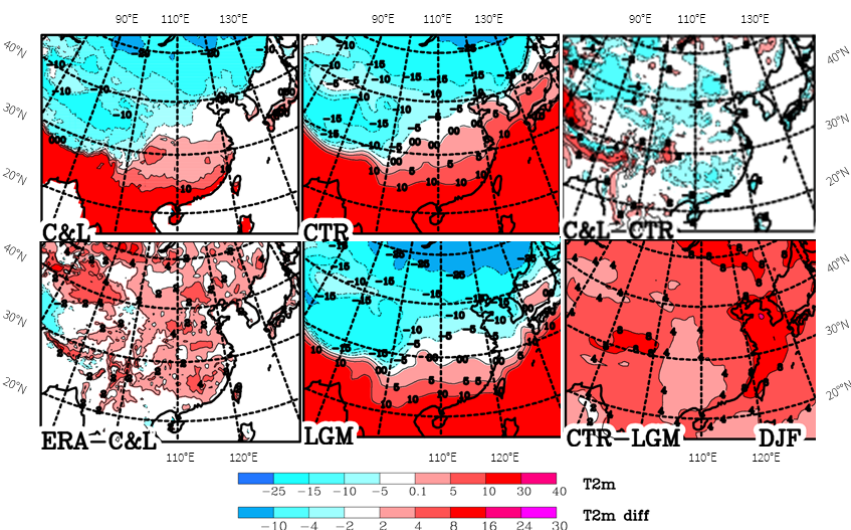
Figure 1. Climatological mean distribution of T2m over eastern Asia for December to February (DJF). Values by Leemans and Cramer (1991) (C&L), the ECMWF reanalysis (ERA-Interim) and model simulations (CTR and LGM), as well as some differences be- tween them.